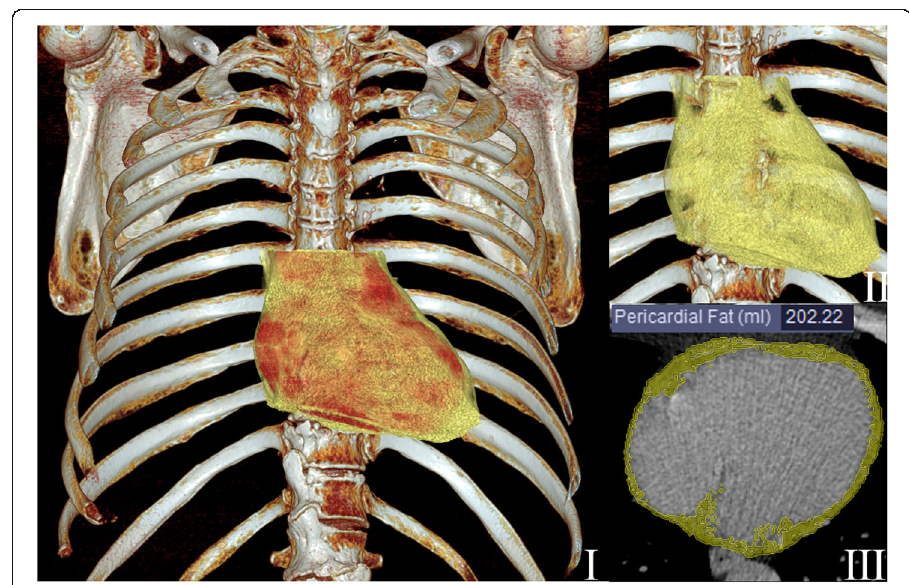
Fig. 4 Schematic diagram of epicardial adipose tissue. Two 3D volume rendering images ( I and II ) and an